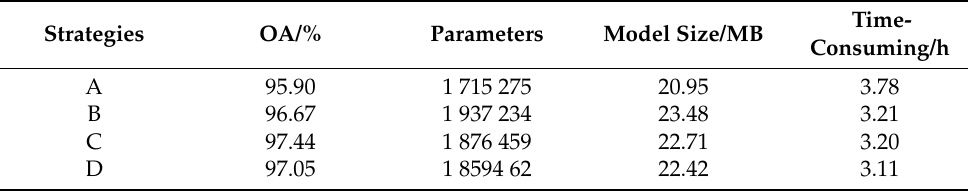
Table 6. Effect of different reduction strategies on model accuracy and model size.